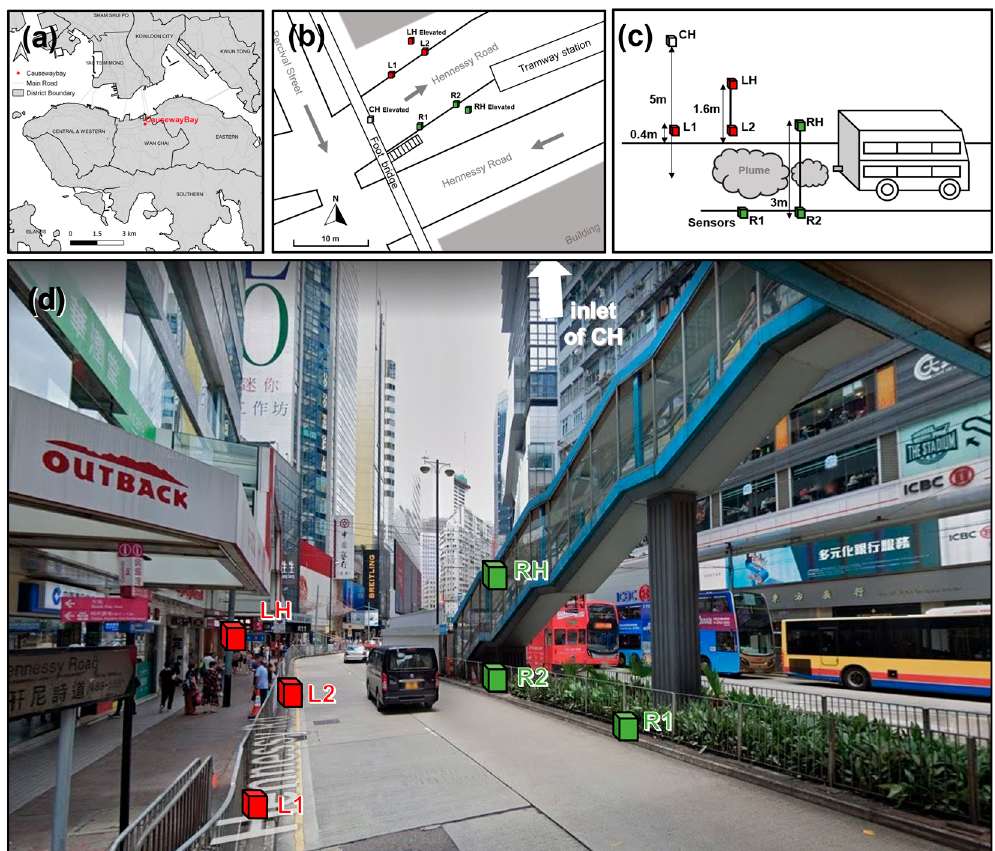
Figure 1. ( a ) Location map showing Causeway Bay on the northern part of Hong Kong Island. ( b ) Layout of the site at Causeway Bay. ( c ) Positions of the sensor nodes. ( d ) Photograph illustrating the site on Hennessy Road, looking east (© Google, June 2019). Tall buildings create an urban canyon and a canopy (OUTBACK) over L1, which shelters pedestrians on the pavement. A tram track (a red tram is partially obscured by the lower end of the staircase) separates the counter-flowing traffic (here seen as buses). At the top right, a portion of the overhead walkway is apparent, where node RH was installed.